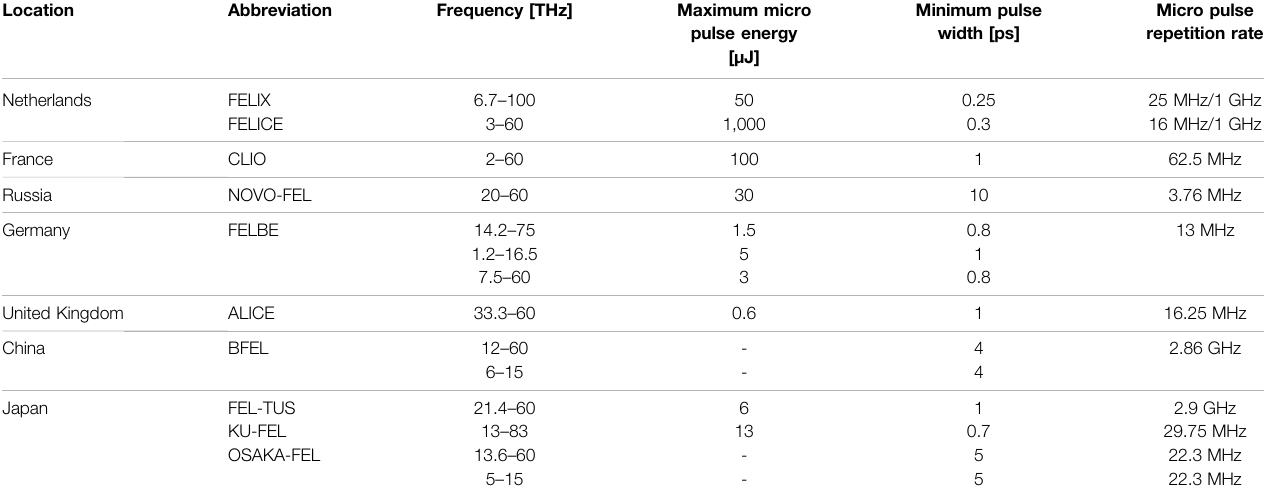
TABLE 1 | THz/IR FEL sources worldwide. Parameters taken from